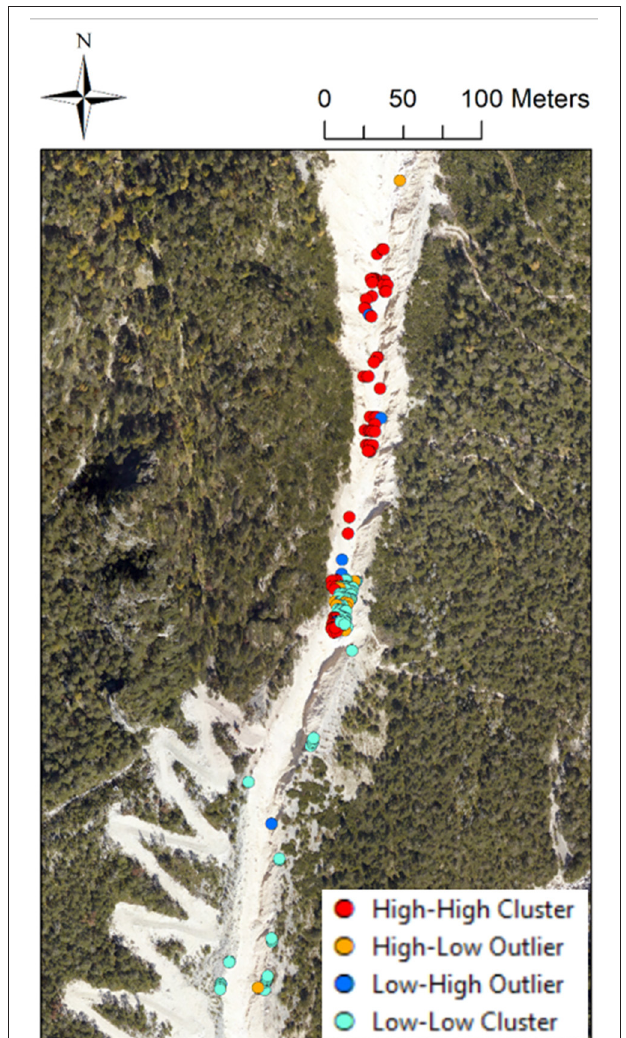
FIGURE 6 | Local Moran’s I index map of the thin-plate spline function absolute errors (spatial resolution of 1.00m). Note the local clusters of high and low errors values mainly located along the upper part of the channel where the topographic roughness is higher due to the presence of boulders and bank failures. Furthermore, local outliers concentrate near the rock step at an altitude of about 1,500m